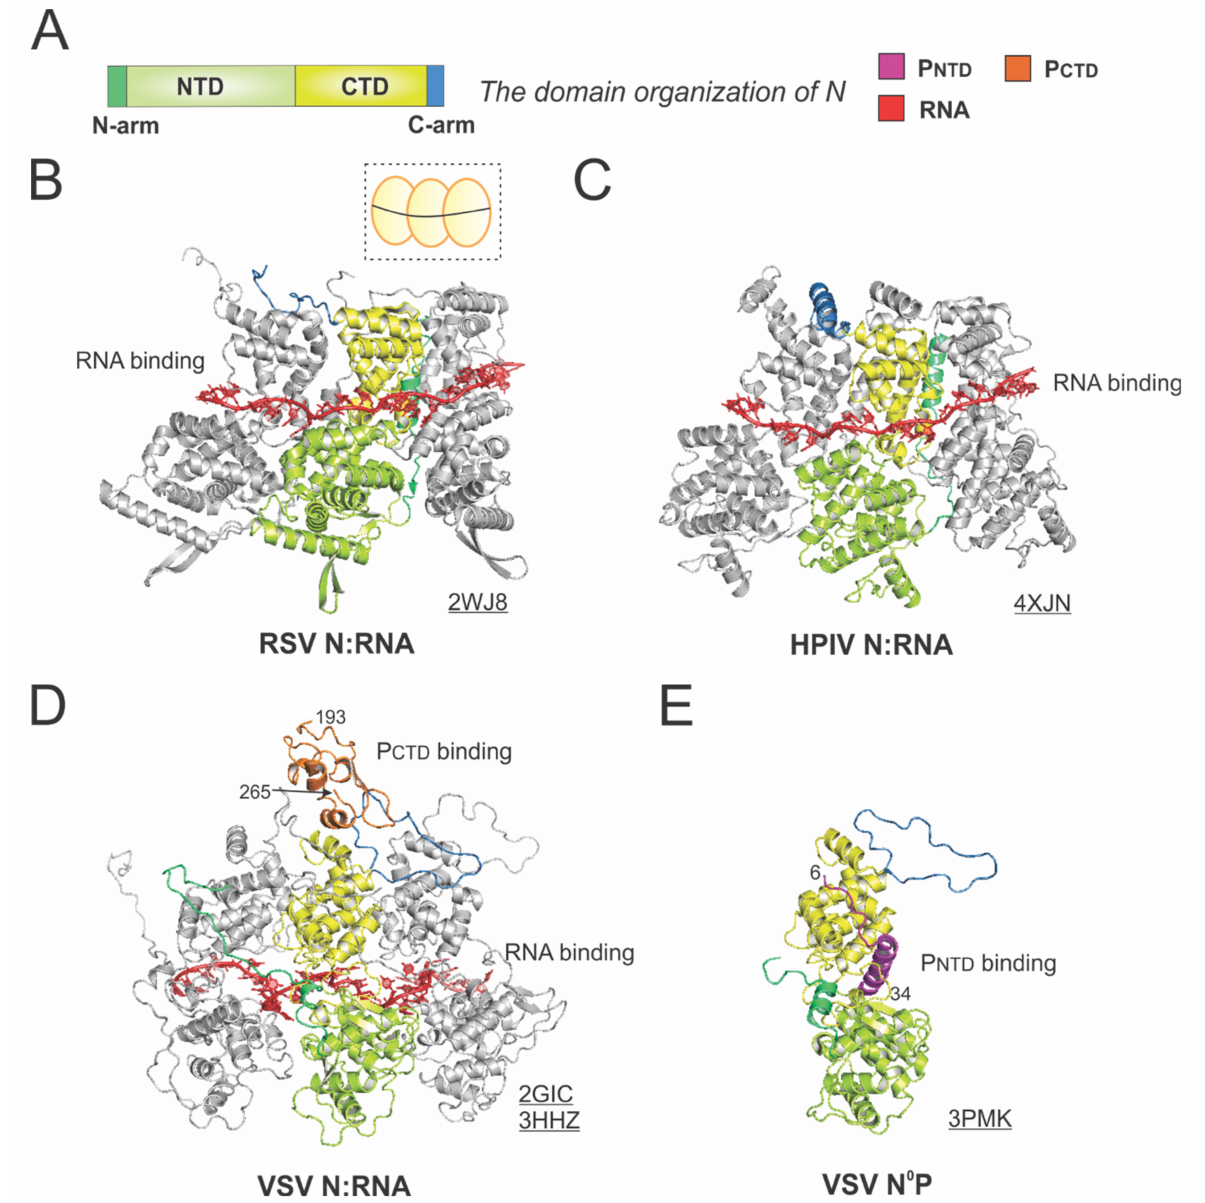
Figure 5. The structures of the nucleoprotein (N) or nucleocapsid (NC) from RSV and other representative viruses. ( A ) The linear domain organization of the N protein. There are two core domains: the N-terminal domain (NTD, light green) and the C-terminal domain (CTD, yellow), plus the N-terminal motif (N-arm, green) and C-terminal motif (C-arm, blue) near the terminus of the core domains. ( B ) The model of the RSV N:RNA is extracted from the crystal structure of the RSV N:RNA (PDB: 2WJ8). The cartoon representation of the RSV N:RNA is shown in the dotted box, with N as the yellow circles (consistent with Figure 1) and the RNA as the black line. ( C ) The model of the HPIV N:RNA is extracted from the crystal structure of the HPIV N:RNA (PDB: 4XJN). ( D ) The models of the VSV N:RNA are extracted from the crystal structure of the VSV N:RNA and NC:P (PDBs: 2GIC, 3HHZ). The P CTD is colored in orange, consistent with Figure 4. ( E ) The crystal structure of the VSV N ◦ P (PDB: 3PMK). Three protomers are shown in the N:RNA structures, and only the middle protomer is colored as the domain organization, and the rest are in gray. The PDB accession codes are underlined. The crystal structure of the RSV N:RNA pseudo-ring revealed that N has two core lobes (NTD and CTD) with the RNA bound in the central groove, and each N coats 7-nt of RNA [13]. Three continuous N subunits are shown, with the middle N highlighted in color and the left and right N molecules in gray. The interacting RNA molecules are colored in red (Figure 5B). Both the N-arm and C-arm of N connect the adjacent N subunits in